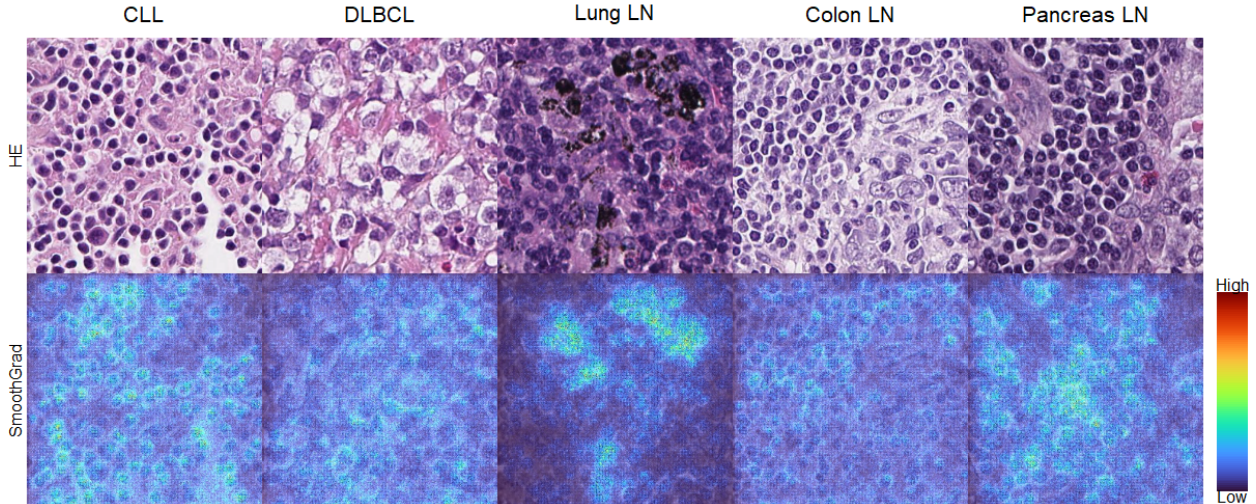
Figure 5. SmoothGrad heatmaps of exemplary patches that were classified correctly. For each class, the upper plot shows the original image patch while the lower plot shows the patch overlaid with the SmoothGrad heatmap with respect to the class of the patch. High SmoothGrad activity scores can be seen in areas overlaid with single cells, as well as in lung LN with extracellular anthracosis. This confirms that the algorithm classified the image patches on the basis of cellular and extracellular morphological structures. DLBCL: diffuse large B-cell-lymphoma, LN: lymph node, SLL/CLL: small lymphocytic lympho-ma/chronic lymphatic leukemia. Magnification: each image 100 × 100 µm (395 × 395 px).